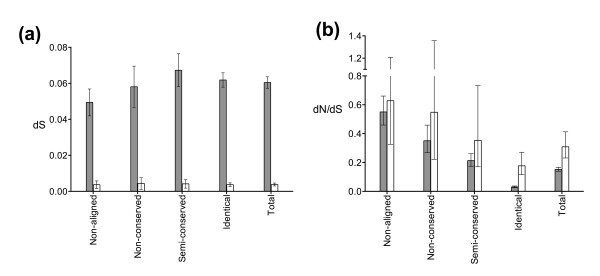
Mutation rates within the hominid malaria clade stratified by conservation level across the Plasmodium genus. (a) Synonymous substitution rates. (b) dN/dS ratios. Data are based on 40 reference genes. Fixed differences between P. falciparum and P. reichenowi are indicated by filled grey bars; polymorphism within P. falciparum is indicated by empty bars. Error bars represent 95% confidence intervals. Conservation levels were based on BLOSUM62 score at individual amino acids in P. falciparum - P. chabaudi alignments; identical (+4 and above), semi-conserved (0 to +3), non-conserved (-4 to -1) and non-aligned.